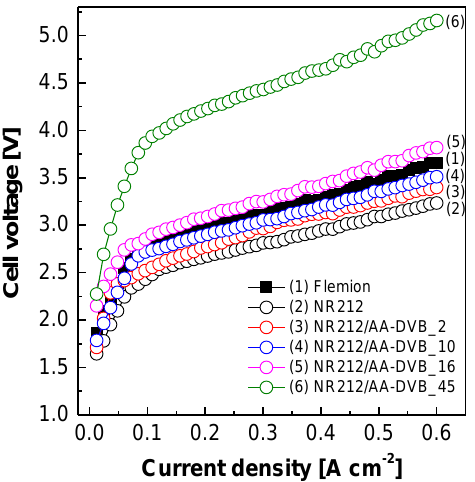
Figure 9. Current–voltage polarization behavior of NR212/AA-DVB membranes at 90 °C.